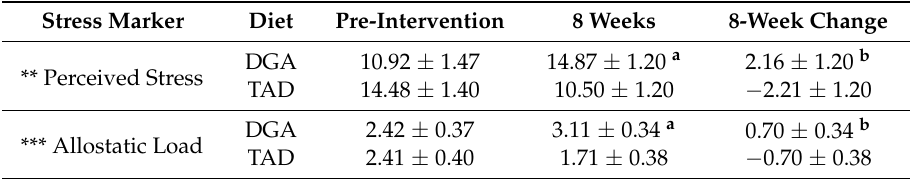
Figure 1. Independent of diet group, increasing the healthy eating index (HEI) for vegetable consumption associated with reductions in the 8 week perceived stress score ( A ). In the right hand figure ( B ), data and regression lines are presented for each diet group (DGA vs. TAD), showing that, for a given magnitude of delta HEI vegetables, the DGA group had a higher magnitude of perceived stress change. No statistical interaction between diet group and change in HEI vegetables was observed ( p = 0.5062), suggesting the regression slopes between DGA and TAD groups were not different, with both demonstrating an inverse association between delta HEI vegetables and delta perceived stress. Data and regression lines presented in A and B were statistically adjusted for age, education, BMI, and pre-intervention perceived stress score.